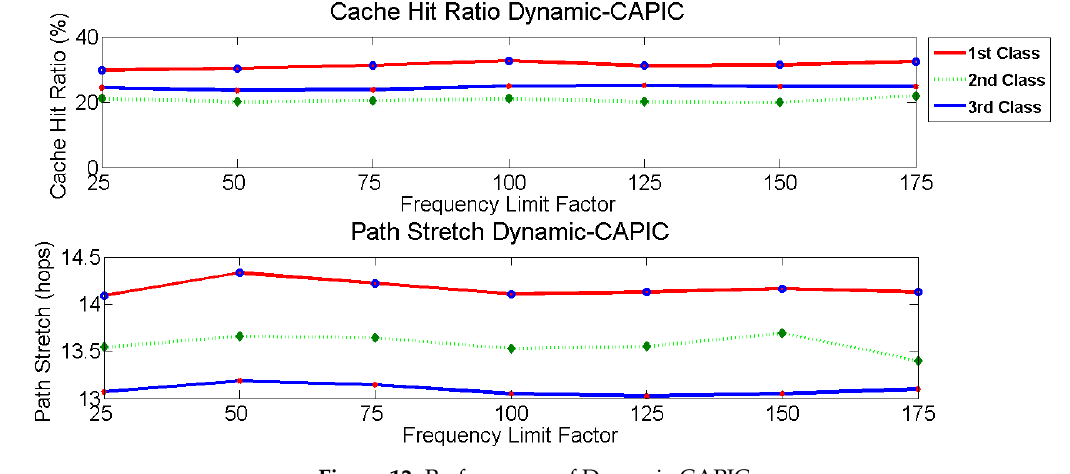
Figure 12. Performance of Dynamic-CAPIC.